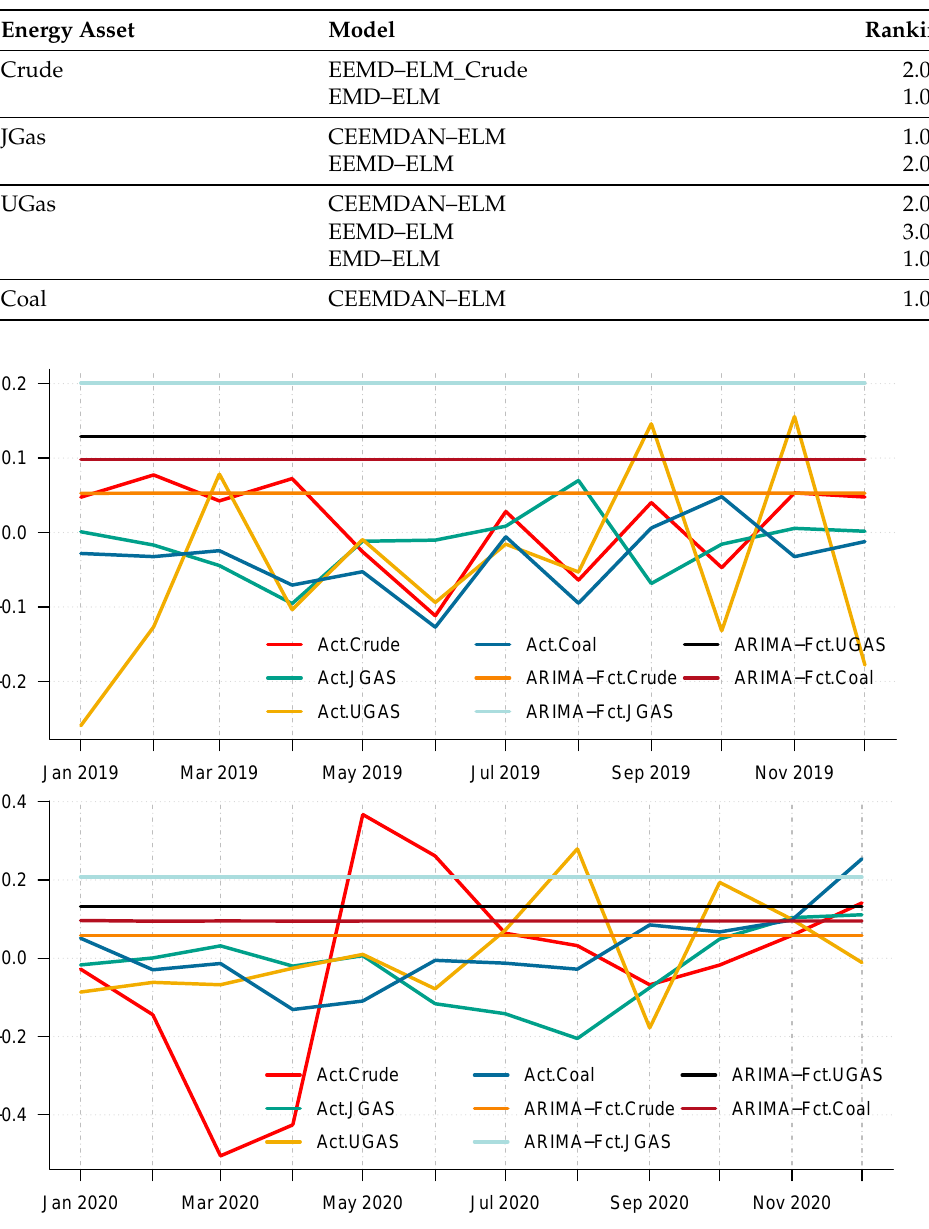
Figure 15. Actual price return series versus price return ARIMA-based forecast in 2019 and 2020. ( top ) Panel A: Actual price return series versus ARIMA-based price return forecast of crude oil, gas, and coal in 2019. ( bottom ) Panel B: Actual price return series versus ARIMA-based price return forecast of crude oil, gas, and coal in